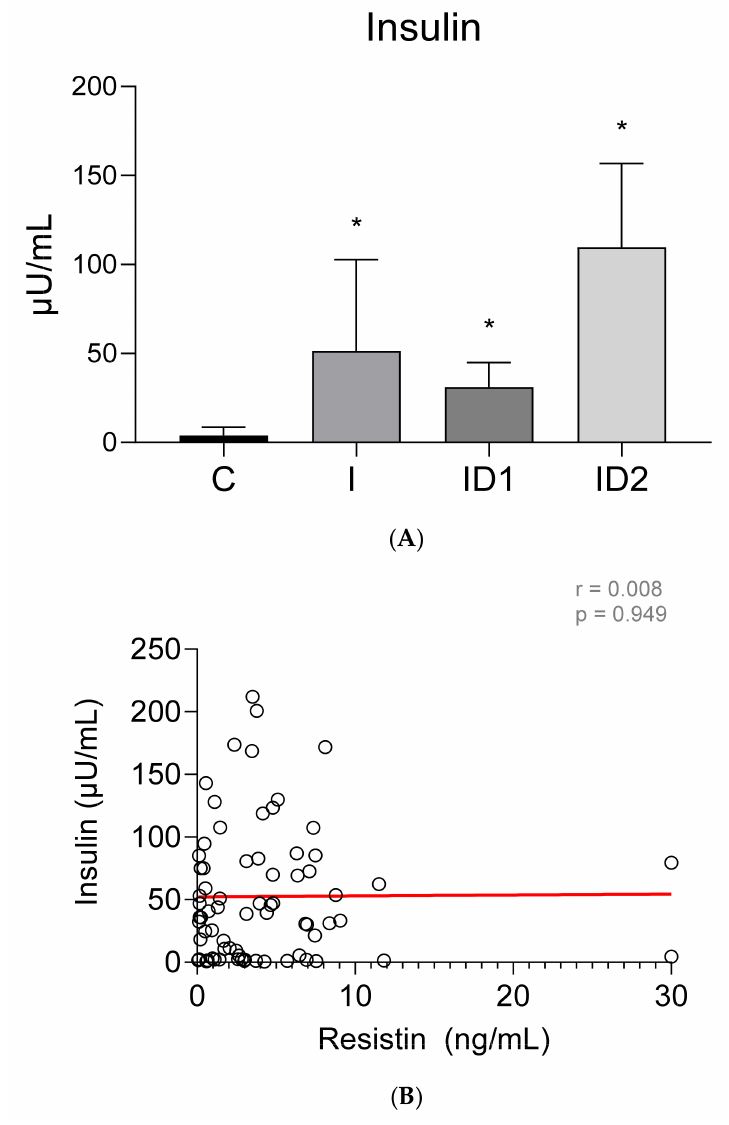
Figure 3. ( A ) Plasma insulin concentration ( µ U/mL) in the different groups. Control group (C) n = 14, inflammatory group (I) n = 21, mild insulin resistance group (ID1) n = 18, severe insulin dysregulation group (ID2) n = 19. Bars represent mean + SD. Asterisks indicate significant differences with the control group (* p < 0.05). ( B ) Correlation between the plasma insulin concentration ( µ U/mL) and plasma resistin concentration (ng/mL) in 72 horses. The linear regression line is draw red solid (n = 72, r = 0.008, p =